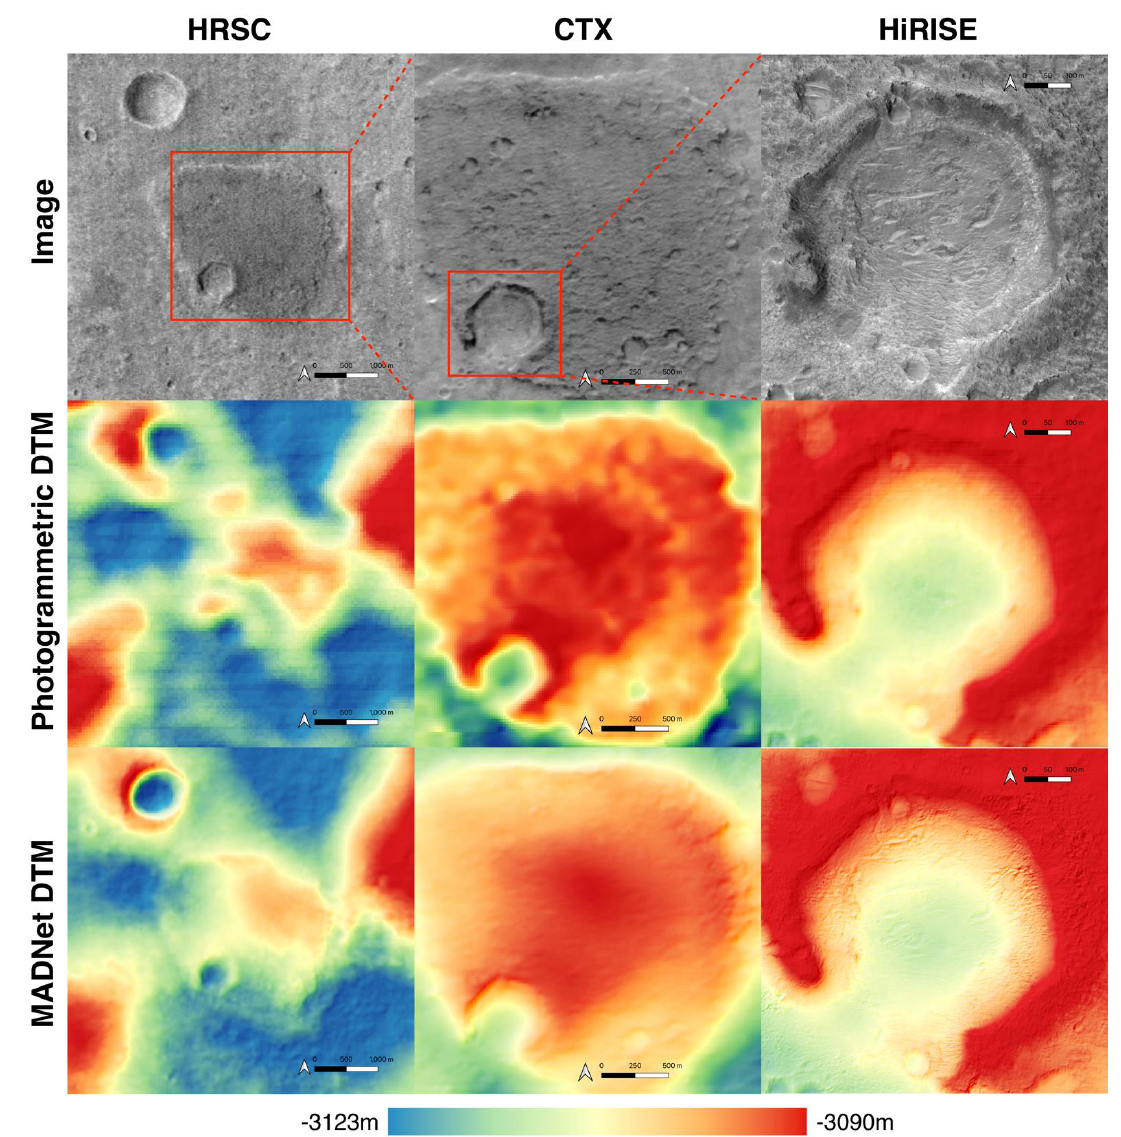
Figure 13. MADNet single-image DTM results for HRSC, CTX, and HiRISE, over a crater and plateau area at Oxia Planum, in comparison to photogrammetric DTM results. Source of photogrammetric DTMs: HRSC (PSA; HMC_11W20_da5); CTX (NHM; CTX_OXIA_DTM_20m_r); HiRISE (PDS; DTEEC_036925_1985_037558_1985_L01). All DTMs are colour hillshaded. To look into details—please refer to the full-resolution figures provided in Supplementary Materials.